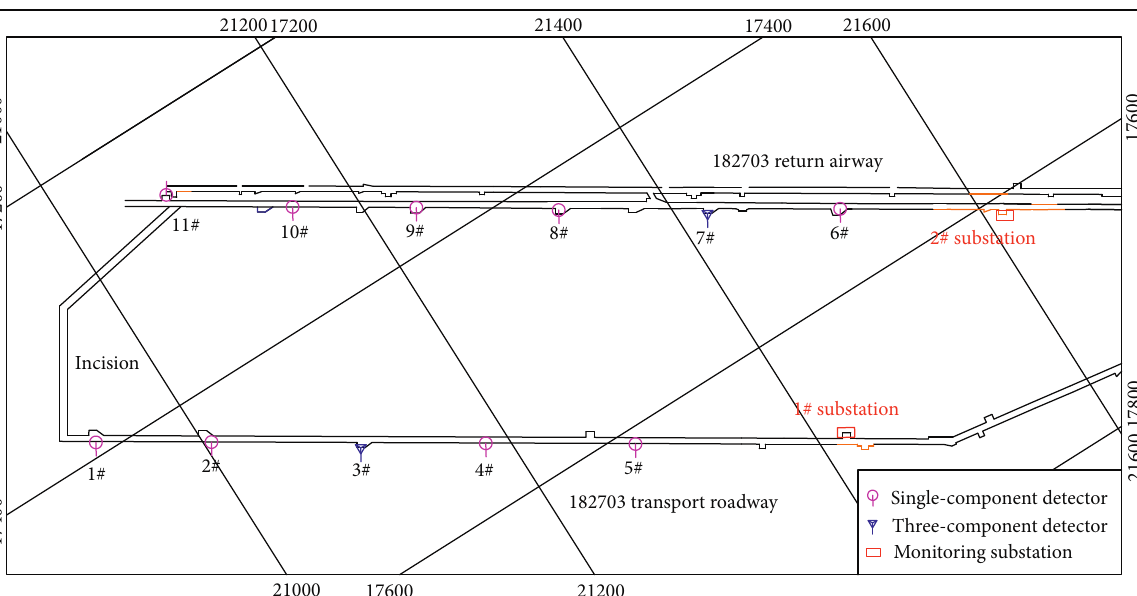
Figure 3: Microseismic monitoring layout of 182703 face in Wutongzhuang